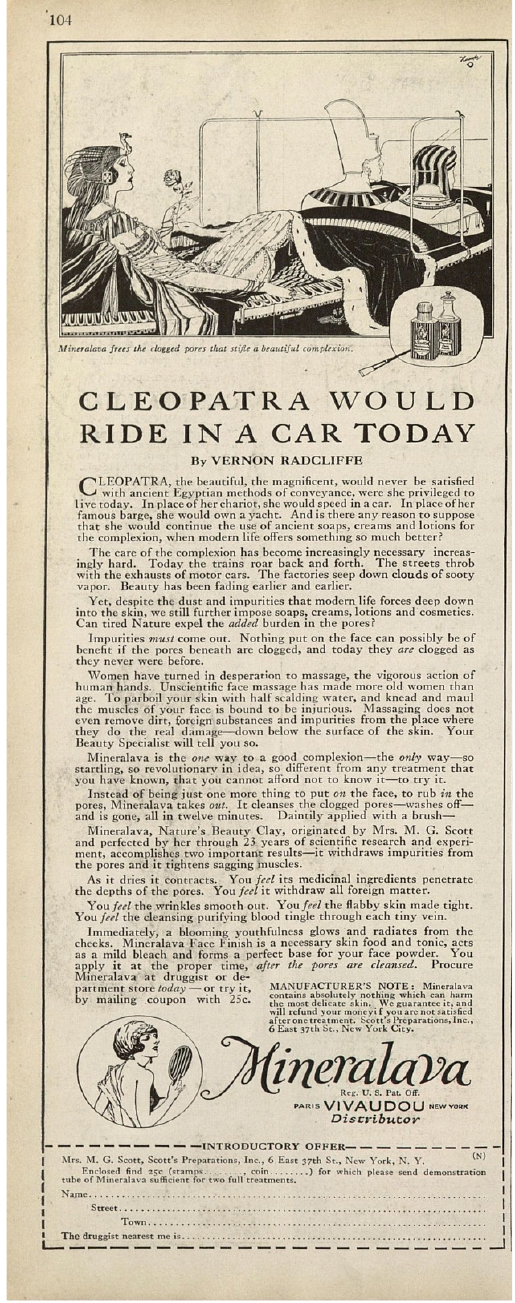
Figure 4. Mineralava Advertisement, Harper’s Bazaar , December 1921, p. 104. (Image published with permission of ProQuest LLC. Further reproduction is prohibited without permission. Image produced by ProQuest LLC as part of Harper’s Bazaar Archive. proquest.com).